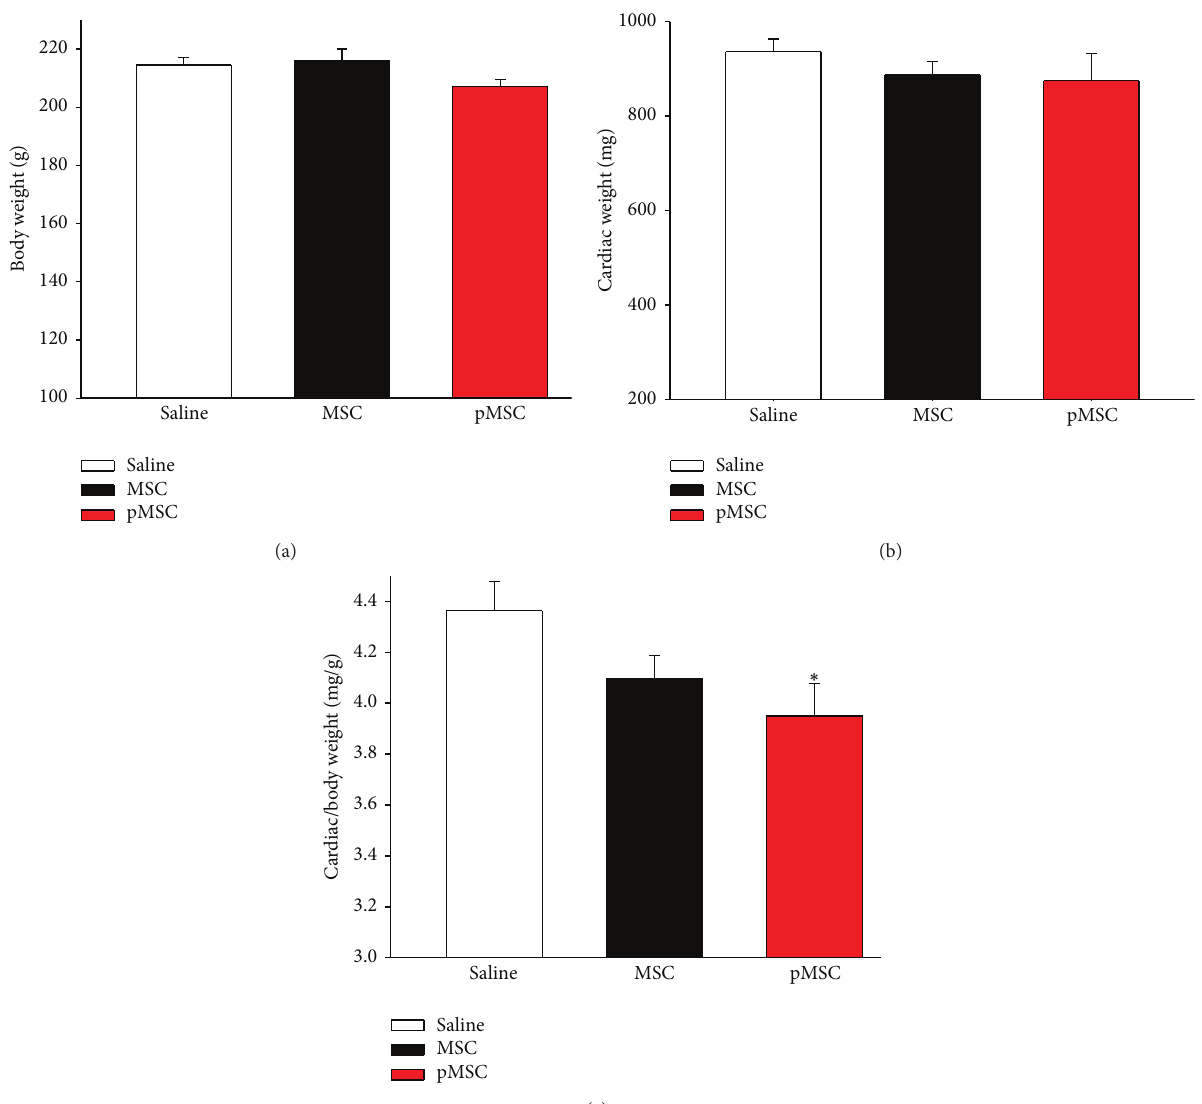
Figure 5: Analysis of cardiac hypertrophy. (a) Values of body weight (g), (b) cardiac weight (mg), and (c) cardiac/body weight ratio (mg/g). Values indicated as the mean ± sem. ∗ 𝑝 < 0.05 versus